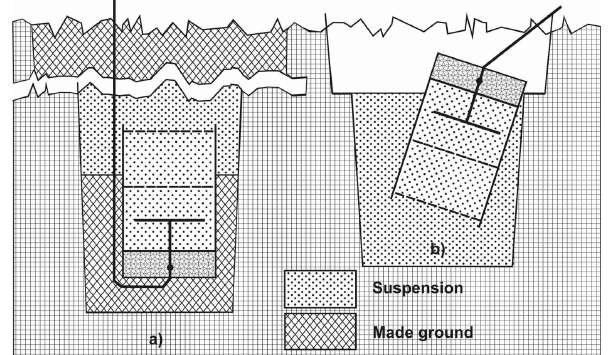
Figure 5. Electrode installation in operation position: (a) long-term and (b) short-term.